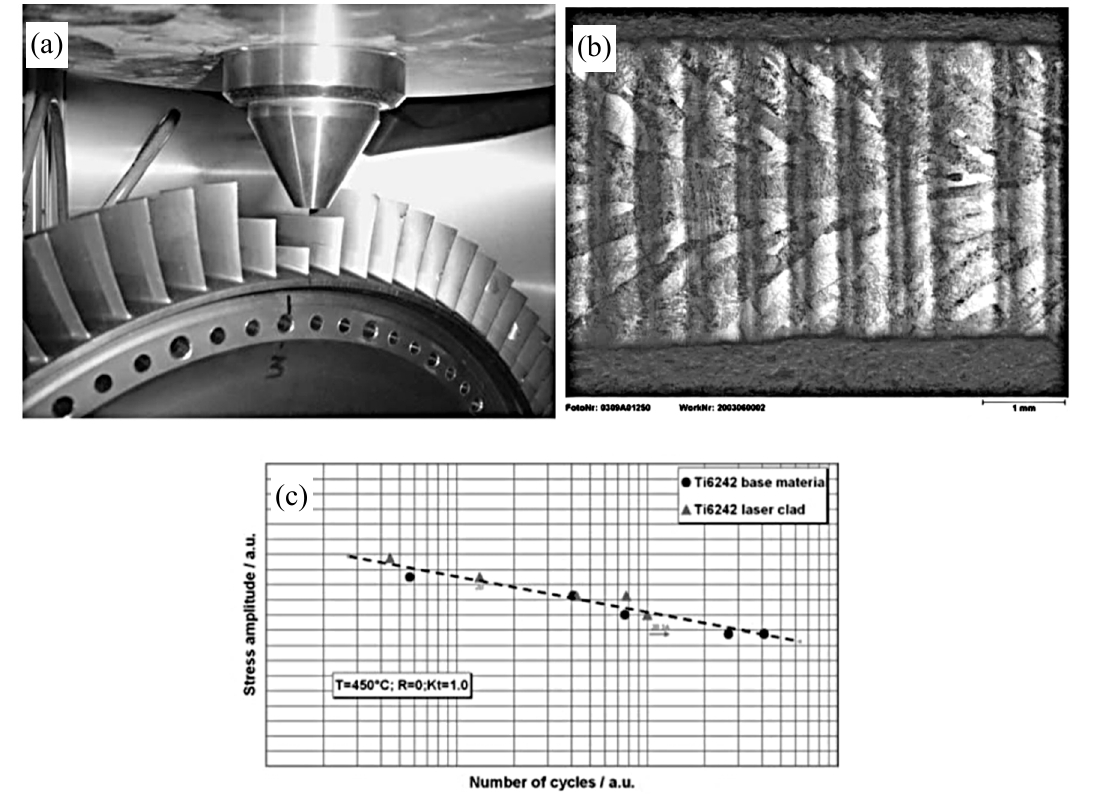
Figure 17. ( a ) Repairing for damaged titanium blisk, ( b ) microstructure of the laser deposited titanium build-up, ( c ) High-cycle fatigue (HCF) results of laser-generated titanium alloy compared to the reference material [101].